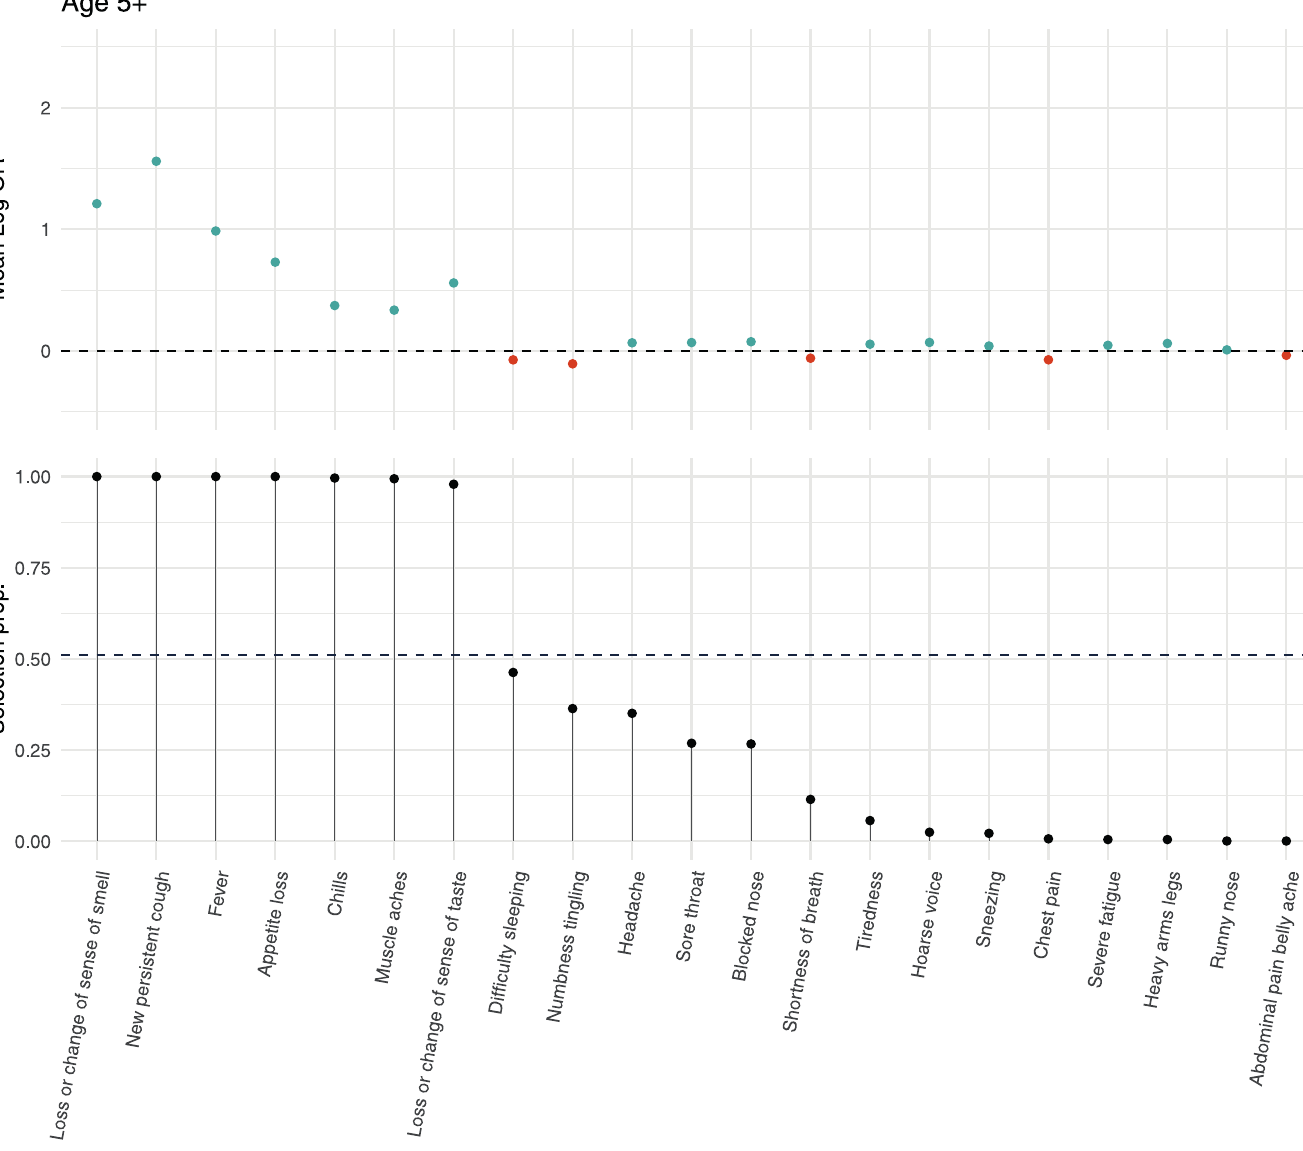
Fig 4. Symptoms predictive of B.1.1.7 infection. LASSO stability selection for symptoms predictive of B.1.1.7 (Alpha) lineage infection versus symptomatic people (aged 5+ years) testing PCR negative in round 8. Mean log odds ratio (Log OR) and selection proportion (selection prop.) are represented for each symptom in the top and bottom panels, respectively. Positive regression coefficients are presented in teal, and negative in